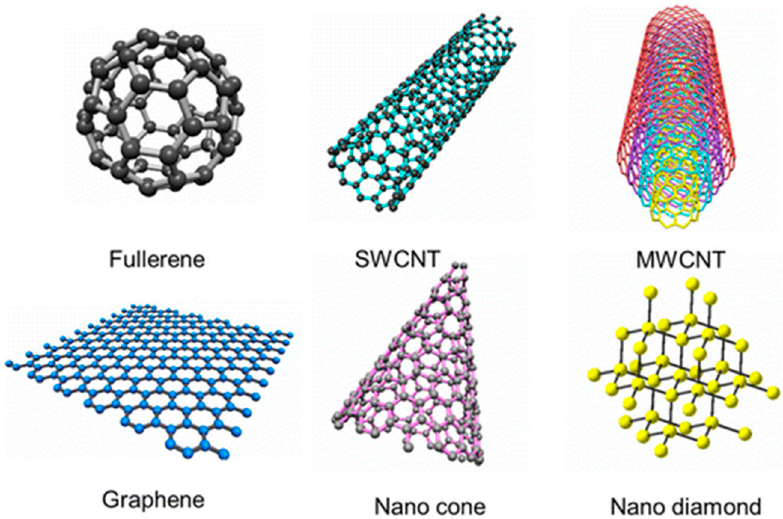
Figure 3. Schematic illustration of some nanocarbon. Reprinted with permission from [79]. Copyright (2013) American Chemical Society.